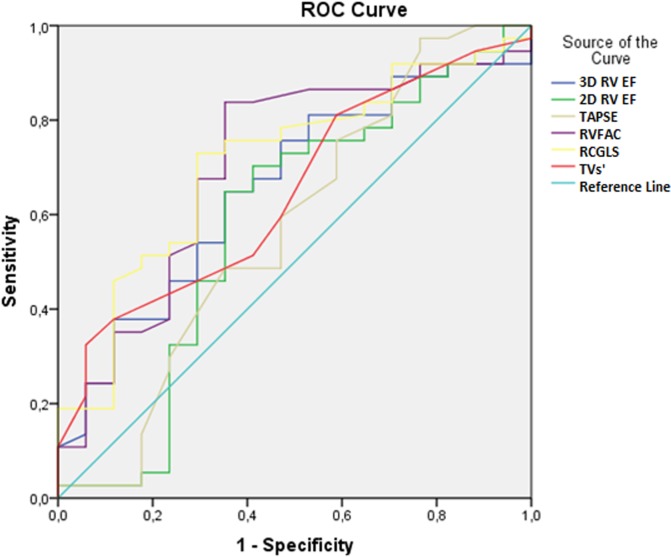
Receiving operating characteristics (ROC) curve for the selected echocardiographic parameters in relation to the peak VO2 values.